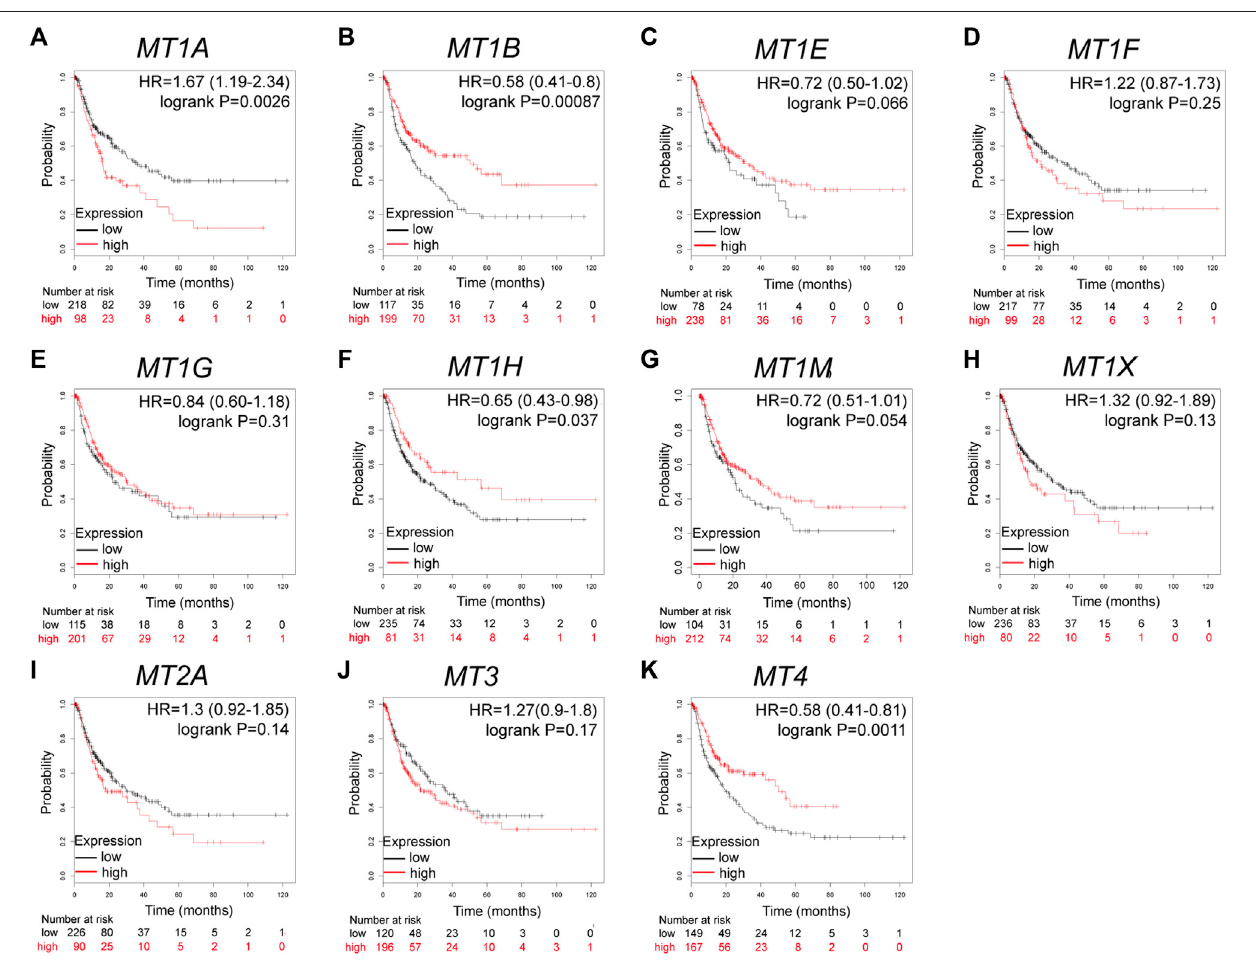
FIGURE 4 | Prognostic values of speci fi c MT isoforms in HCC: (A – K) RFS in Kaplan – Meier plotter. The p -values were calculated by the log-rank test. RFS, recurrence-free